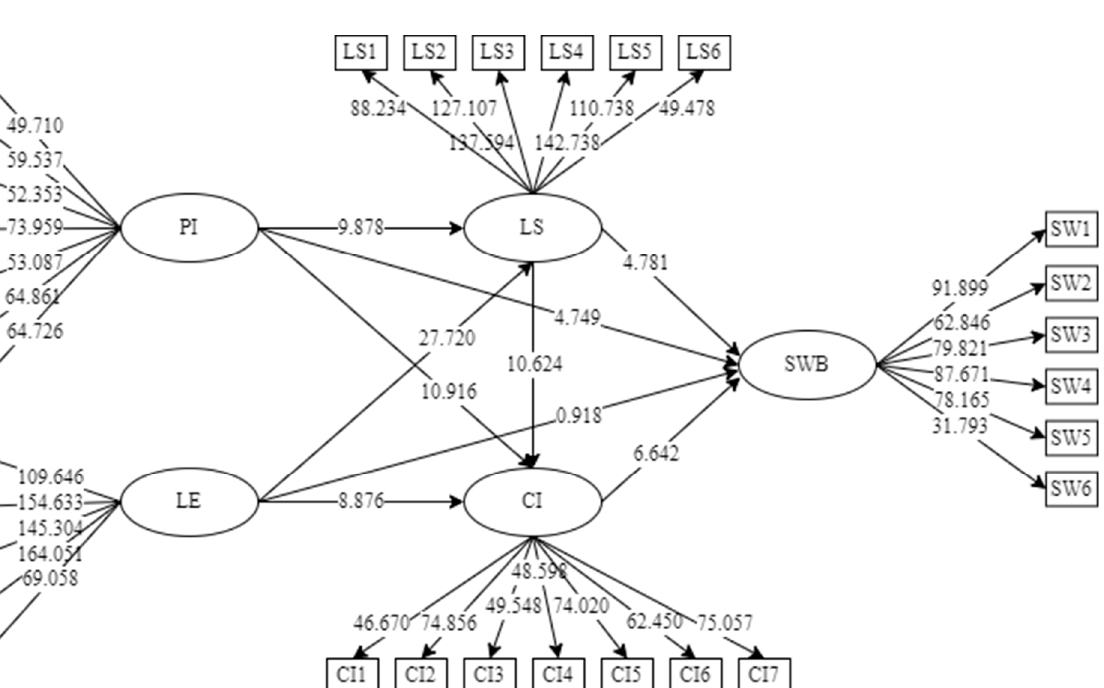
Table 6. The structural relationships and hypothesis testing.